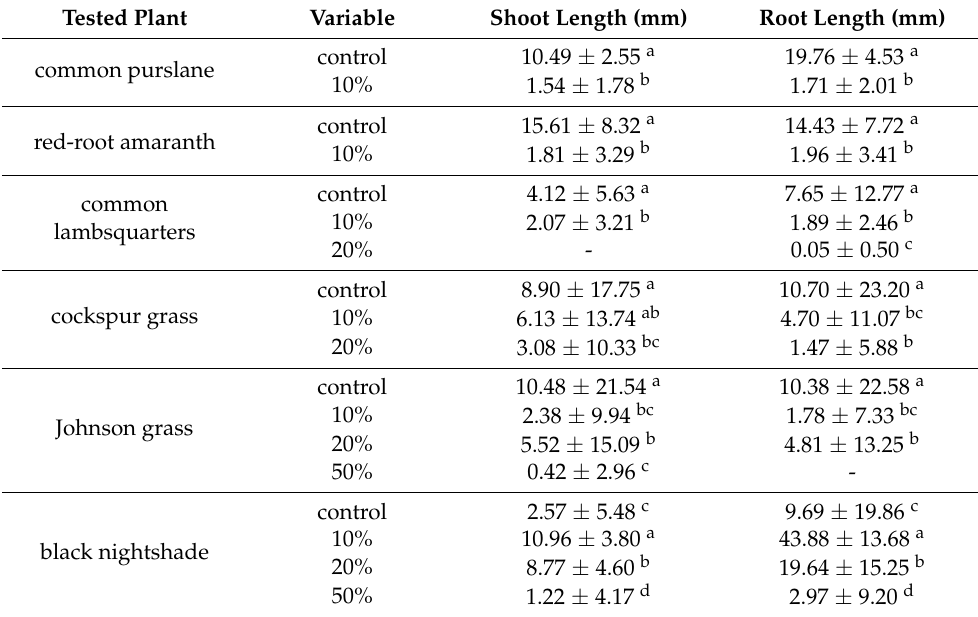
Table 4. The shoot and root seedling length of the weed species treated with 10, 20, 50, and 100% T. vulgaris hydrolate solutions.